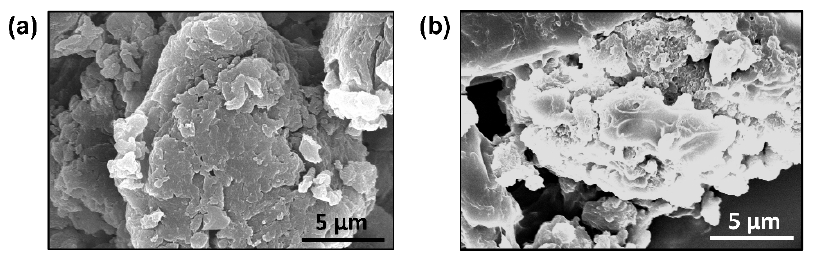
Figure 1. Characterization of PNIPAm-co-PAAm HG. ( a ) 1 H NMR spectrum of PNIPAm-co-PAAm HG. ( b ) FT - IR analysis of PNIPAm - co - PAAm HG without and with Cur. XPS analysis of PNIPAm - co - PAAm HG with ( c ) wide-scan, and core level spectra of ( d ) C 1s; ( e ) N 1s; and ( f ) O 1s.